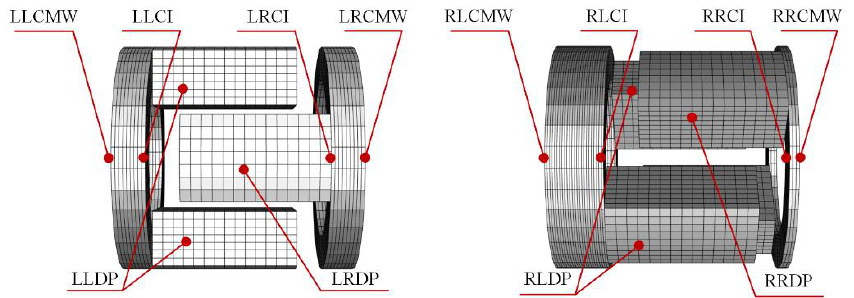
Figure 10. Boundary settings of the two pump units. Aviation hydraulic oil at 40 °C is used as the medium. Under the ambient pressure of 1.01 bars, given liquid has a kinematic viscosity of 13.84 × 10 −6 m 2 /s, an elastic modulus of 1000 MPa, and a density of 850 kg/m 3 .